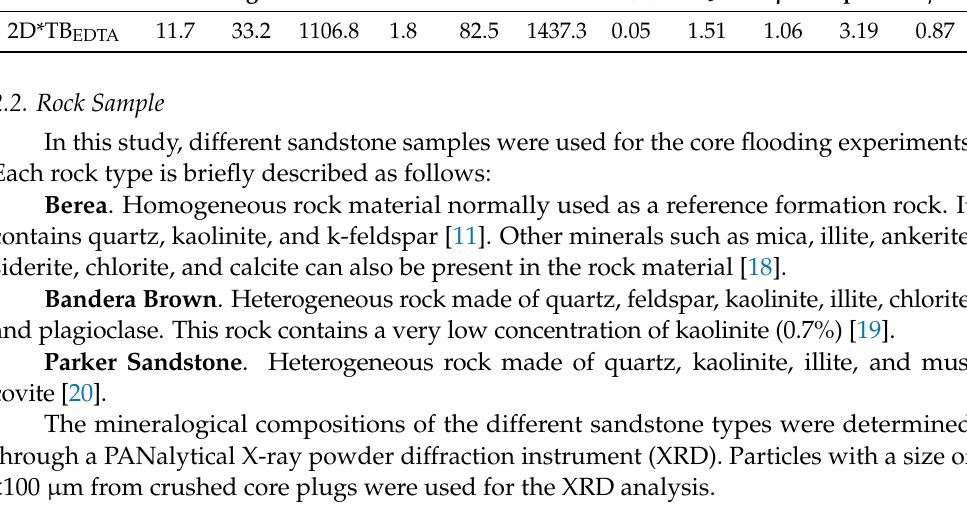
Table 1. Ionic composition in mmol/L and intrinsic properties of diluted Thisted geothermal brine with EDTA (2D*TB EDTA ) used in the experiments. Ionic strength I c in mmol/L, density ( ρ ) in g/cm 3 , pH, and viscosity ( µ ) in cP. Ionic Composition Intrinsic